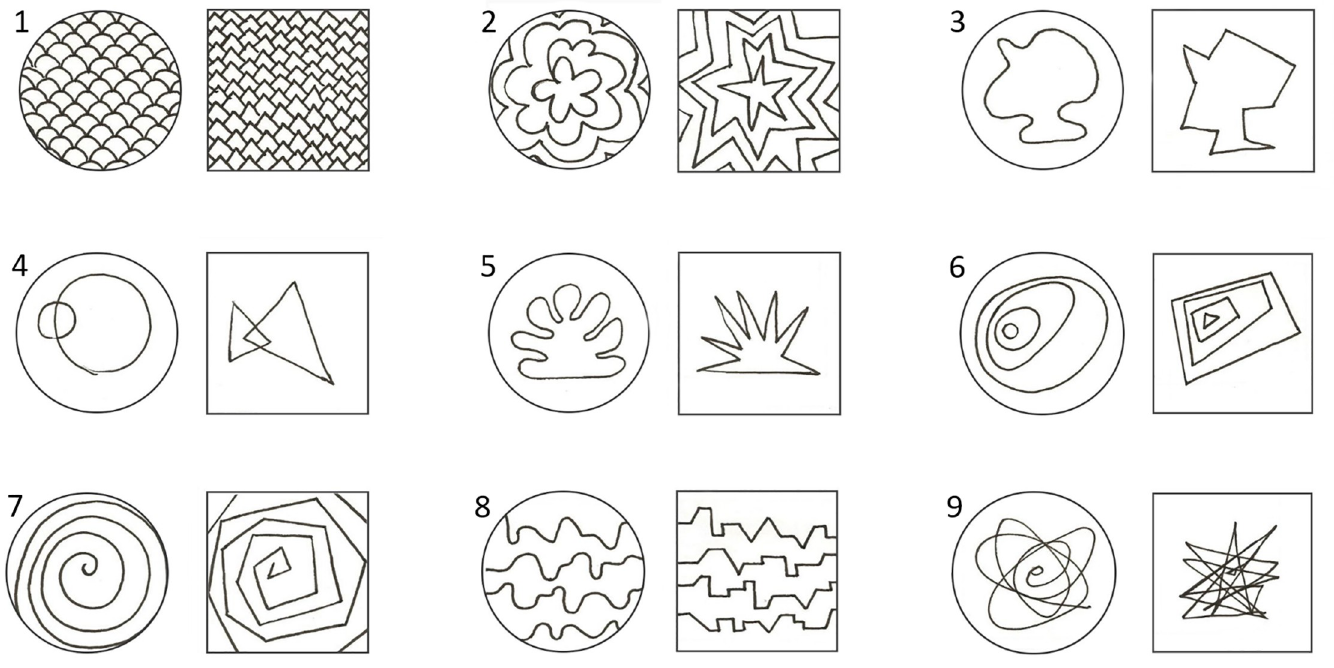
Fig 2. Angular vs. curved drawn pill stimuli used in Study